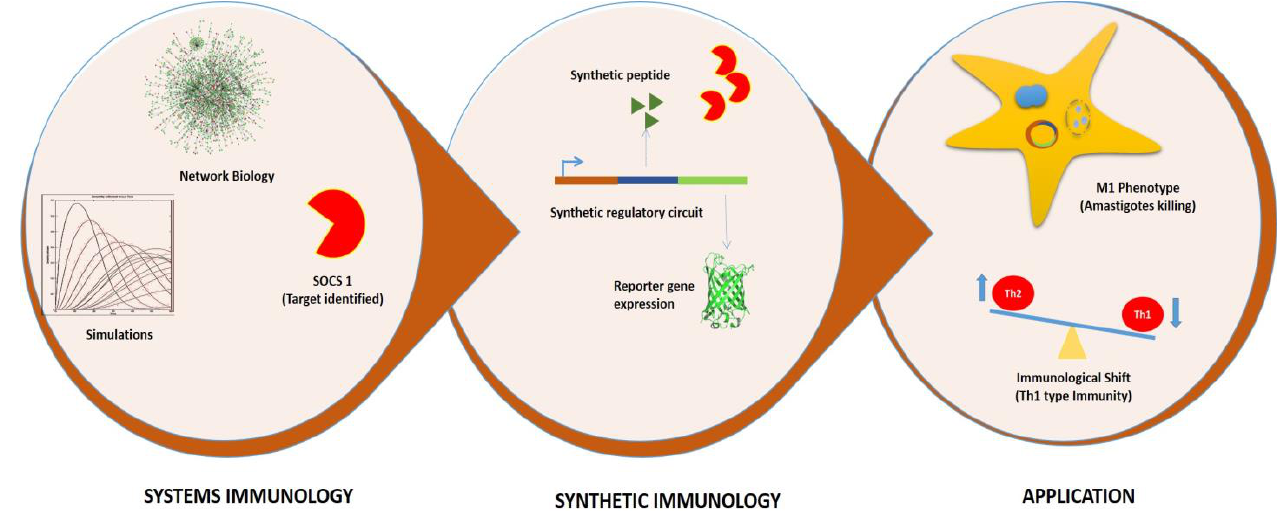
Figure 1. Graphical representation of Systems and Synthetic